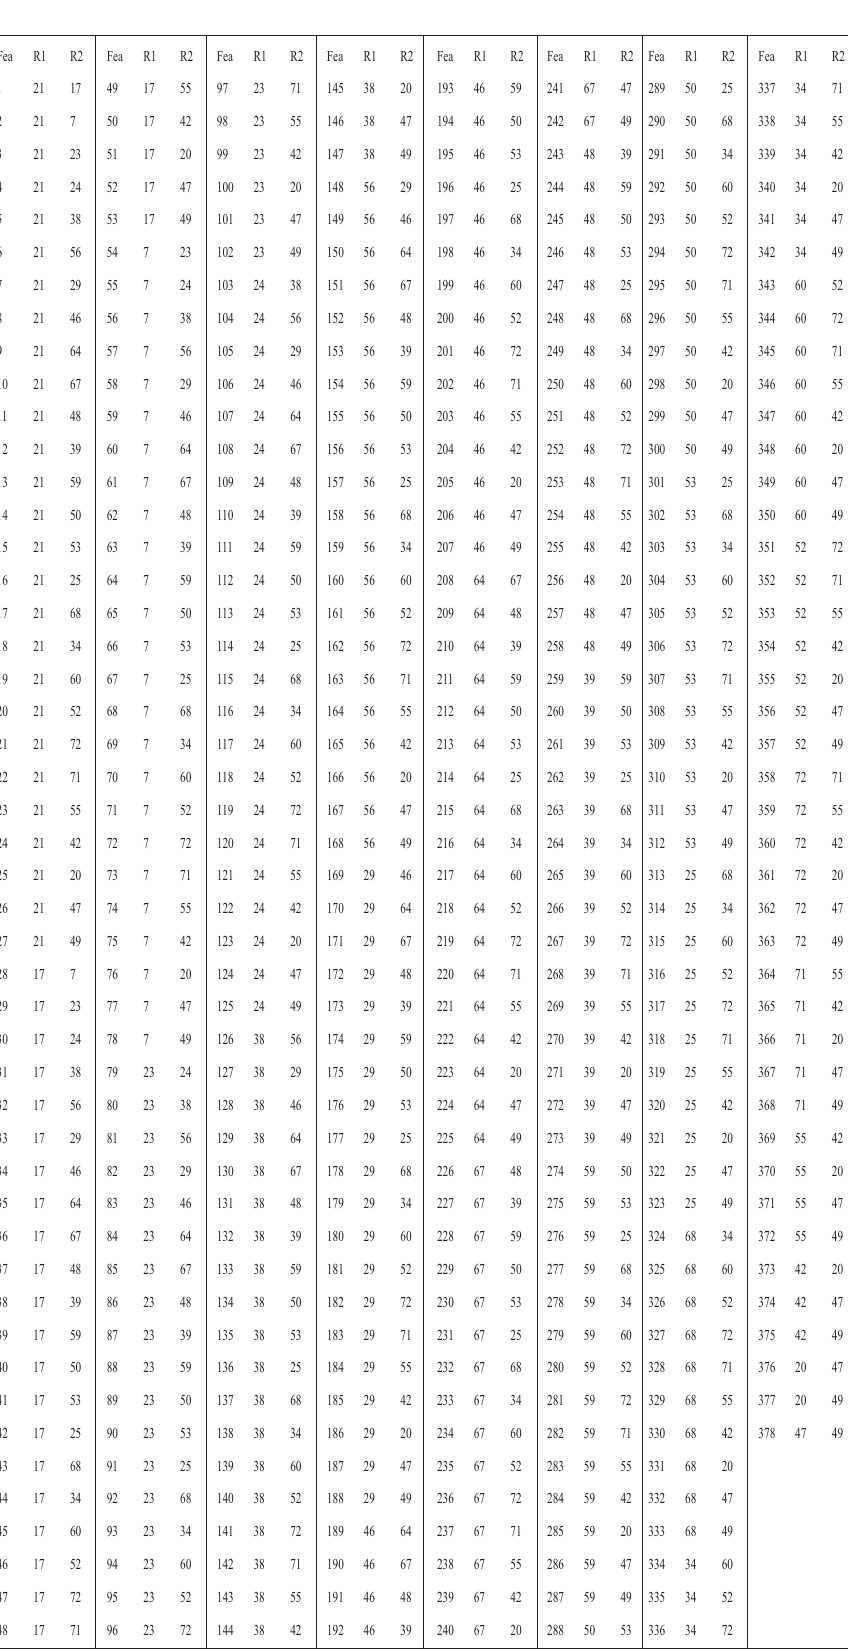
Figure A3. The connections between the brain regions R1 and R2 corresponding to FNC